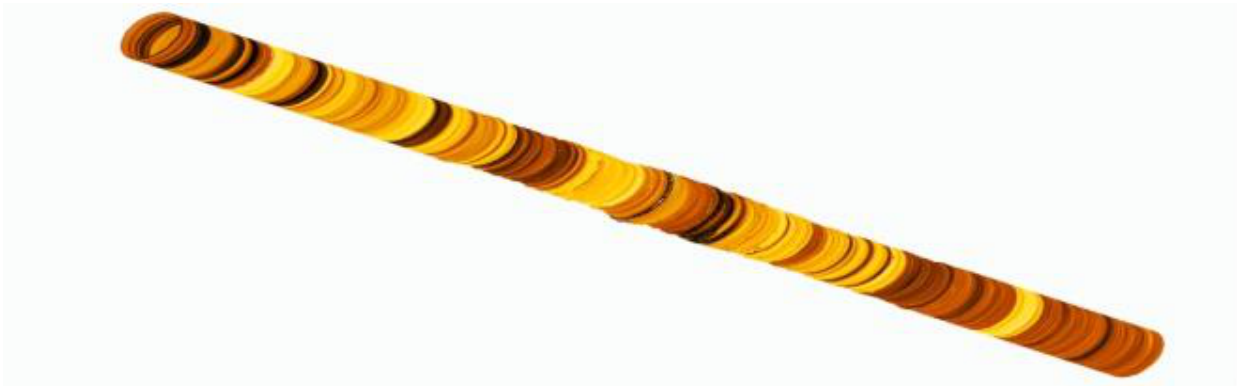
Figure 14. Three-dimensional wellbore with additional gamma imaging data.